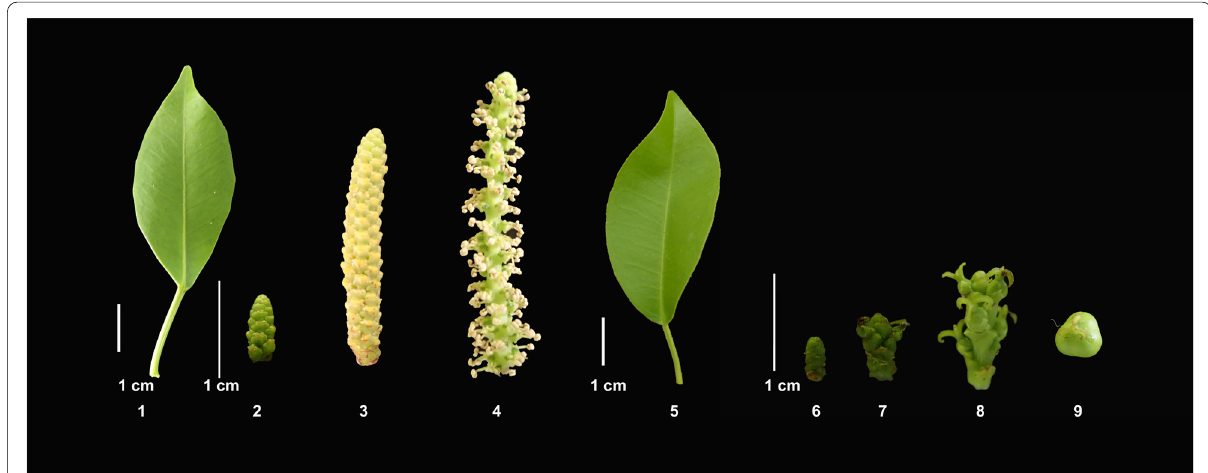
Fig. 1 Plant material used for qRT-PCR analysis. Note: 1 Male leaf. 2 Male flower bud (small). 3 Male flower bud (big), 4 Male flower. 5 Female leaf. 6 Female flower bud (small). 7 Female flower bud (big). 8 Female flower. 9